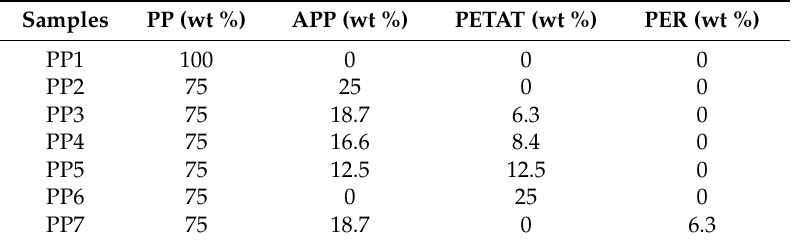
Table 1. Formulations for flame retardancy PP (Polypropylene)